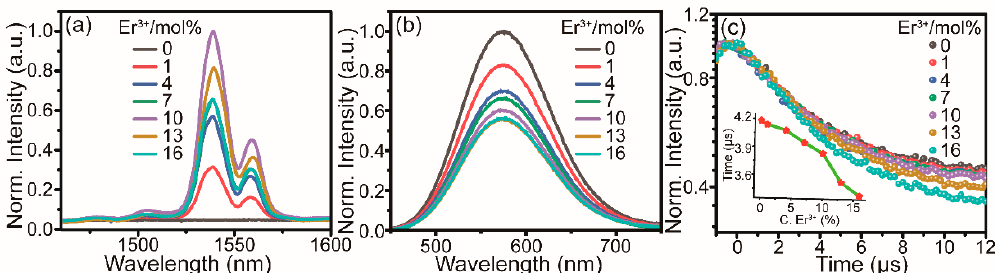
Figure 3. Normalized PL emission spectra ( λ ex = 391 nm) of 1.4% Te 4+ /x% Er 3+ -co-doped Cs 2 SnCl 6 microcrystals ( a ) in the NIR region and ( b ) in the visible region. ( c ) Visible luminescence decay curves of 1.4% Te 4+ /x% Er 3+ -co-doped Cs 2 SnCl 6 ( λ ex = 391 nm and λ em = 577 nm). Inset shows the PL lifetime of 1.4% Te 4+ /x% Er 3+ -co-doped Cs 2 SnCl 6 for the visible emission as a function of Er 3+ concen- tration.